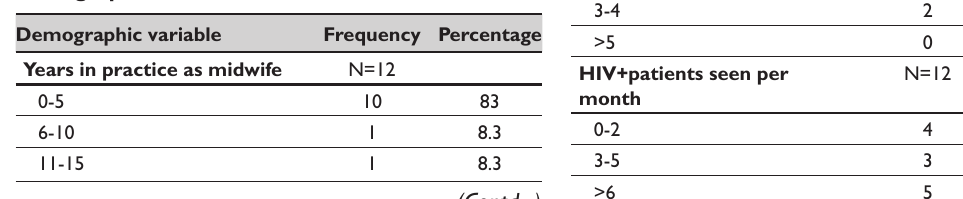
Table 1: Midwives’ training background and clinics’